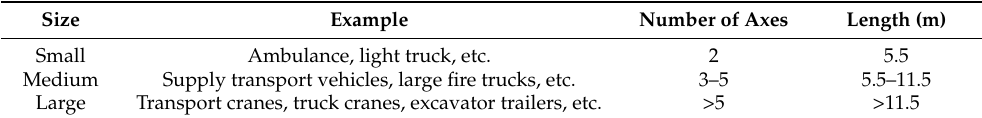
Table 2. Rescue vehicle